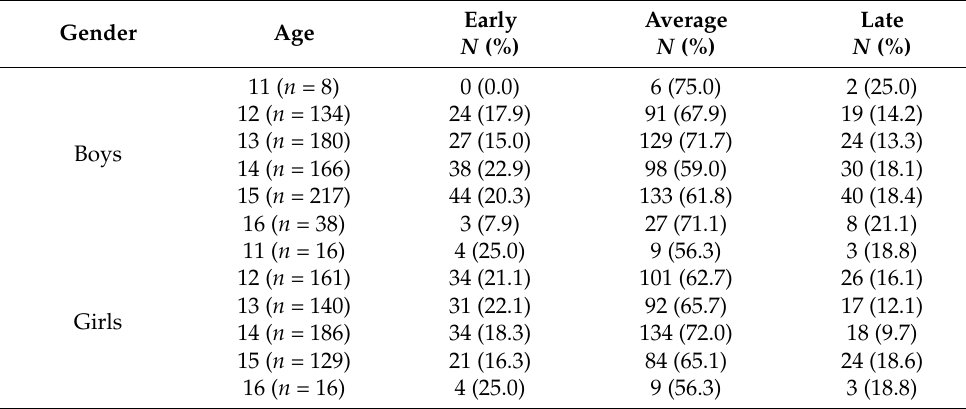
Table 1. PDS categories in groups of genders and